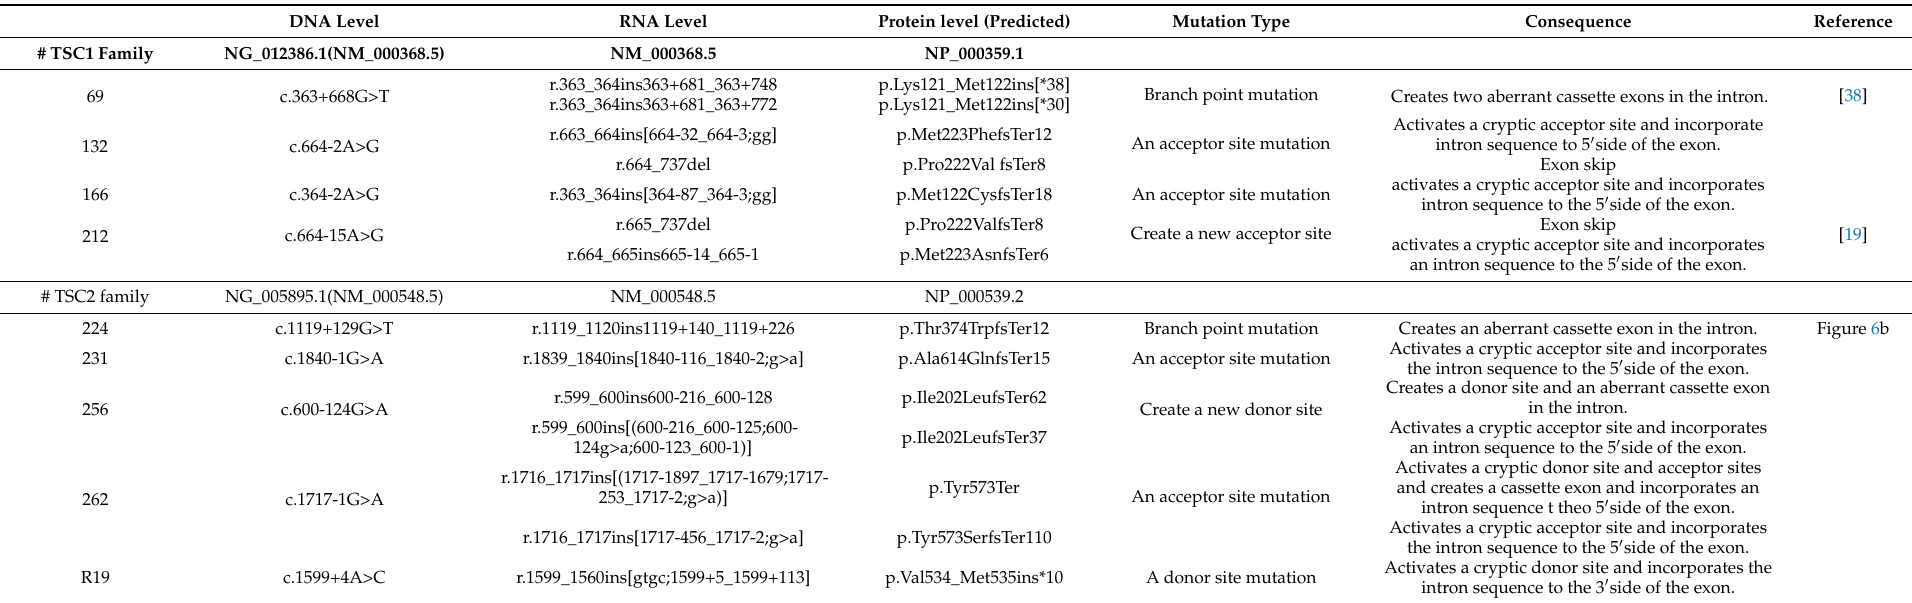
Table 12. Complex consequences of splicing